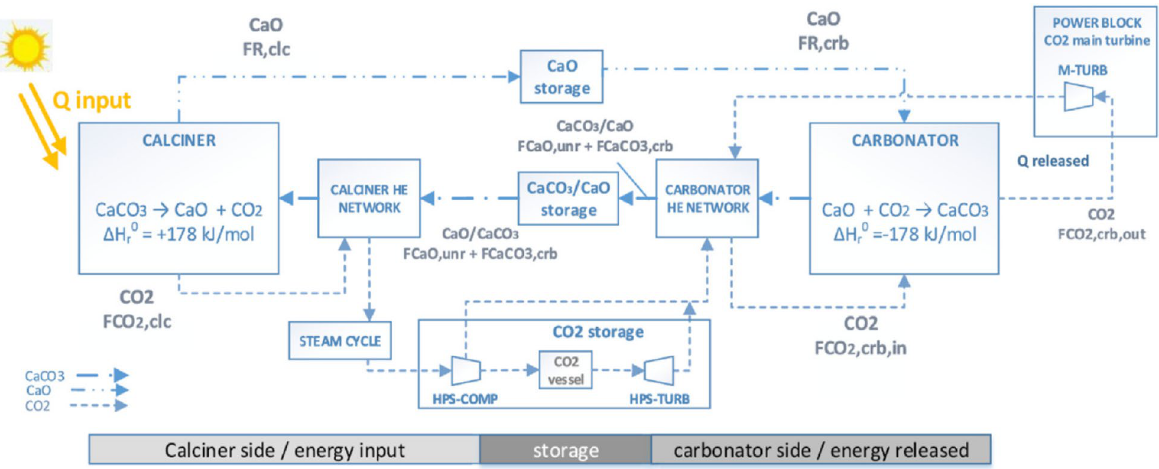
Fig. 13 CSP-CaL integration conceptual scheme and representation of energy storage and release processes